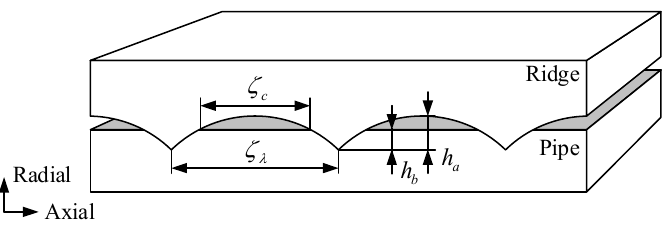
Figure 9. Illustration of the helical streaks embedding into the pipe surface.